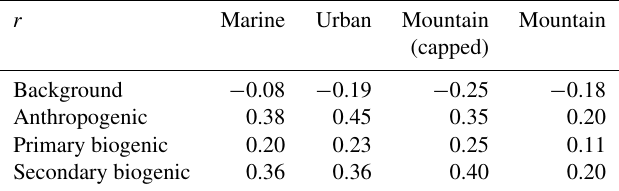
Table 3. Pearson correlation coefficient ( r ) between categorical SRRs (ms − 1 ) and PMF normalized factor contributions.